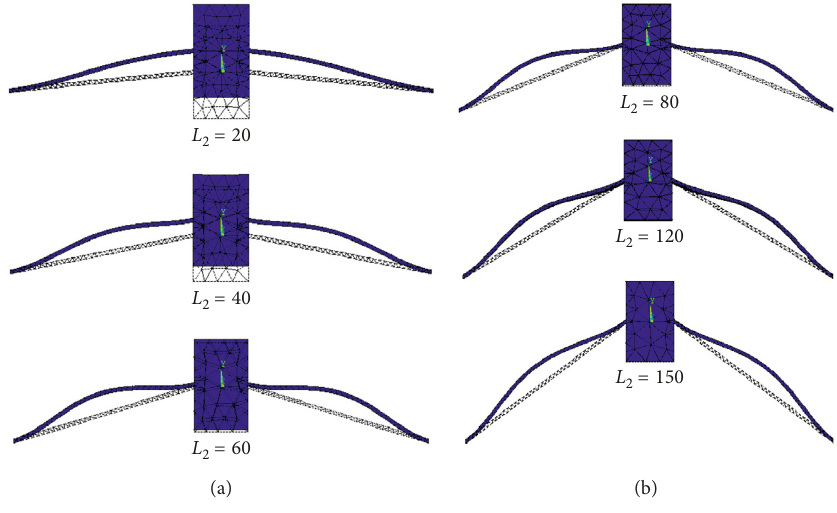
Figure 7: Mode shapes for L